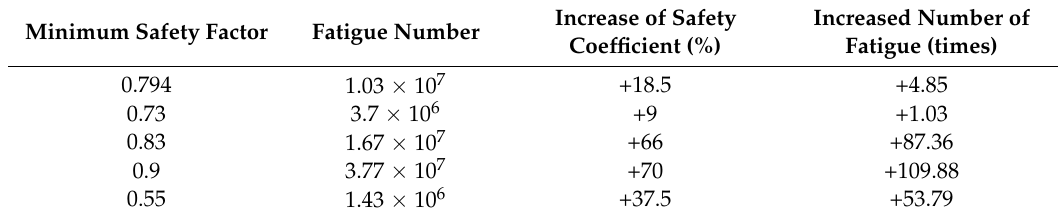
Table 6. Fatigue analysis of end cover